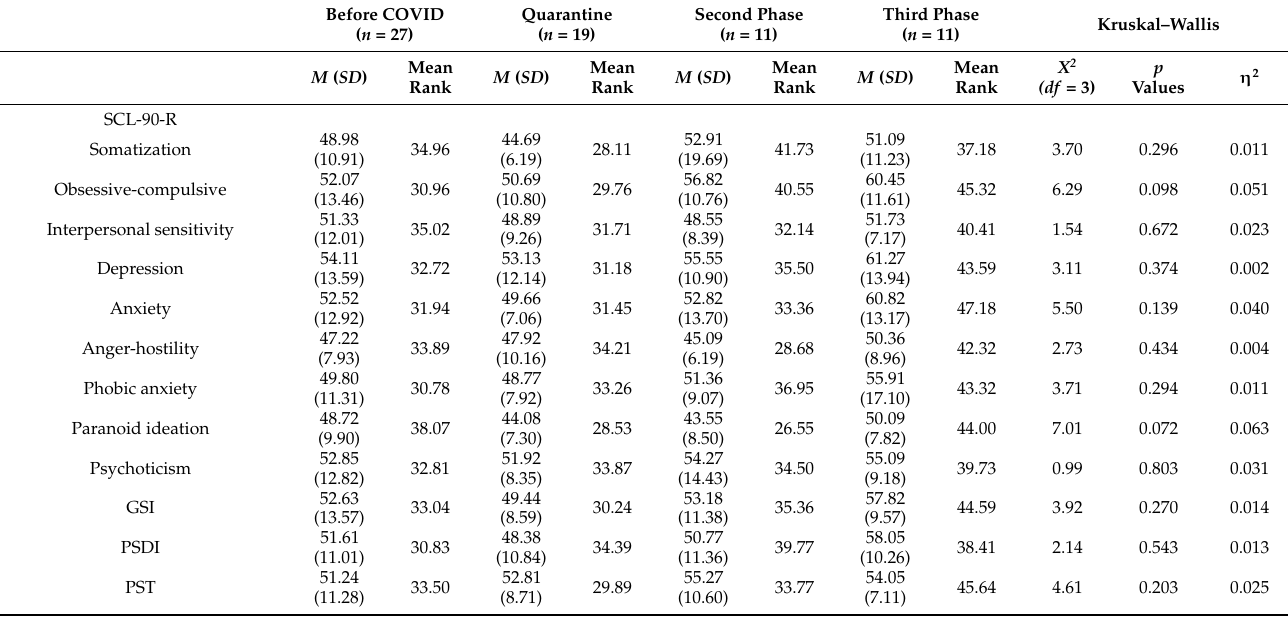
Table 5. Mean ( SD ) score by male groups; Kruskal–Wallis